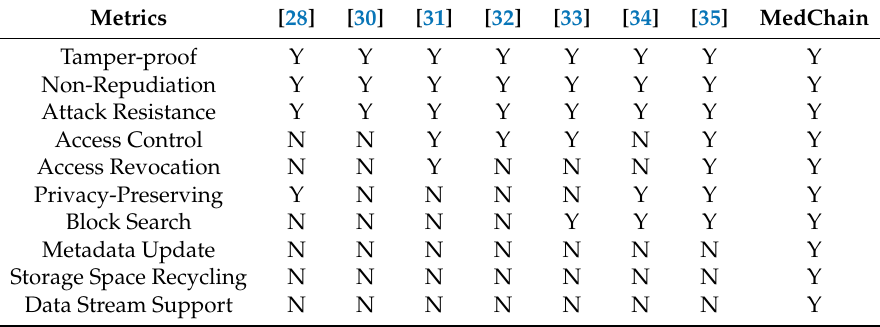
Table 4. Comparison between MedChain and related